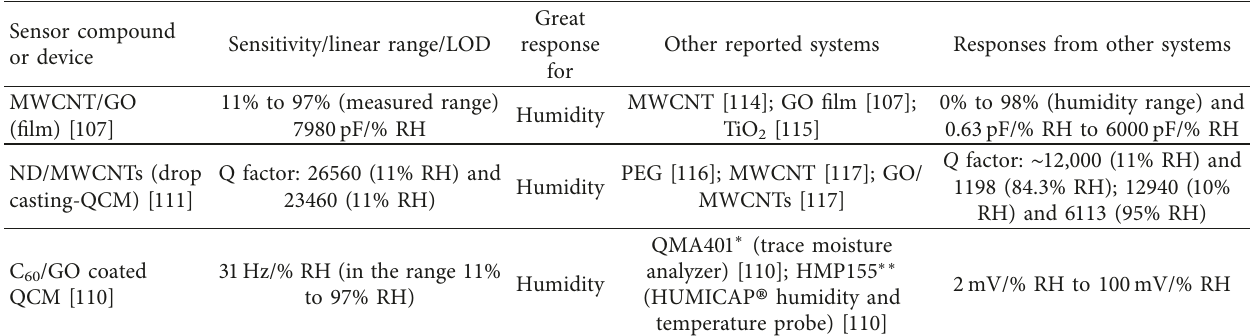
Table 3: Comparison between some of the humidity sensor systems described in this review and other systems found in the literature. Sensor compound Sensitivity/linear range/LOD or device